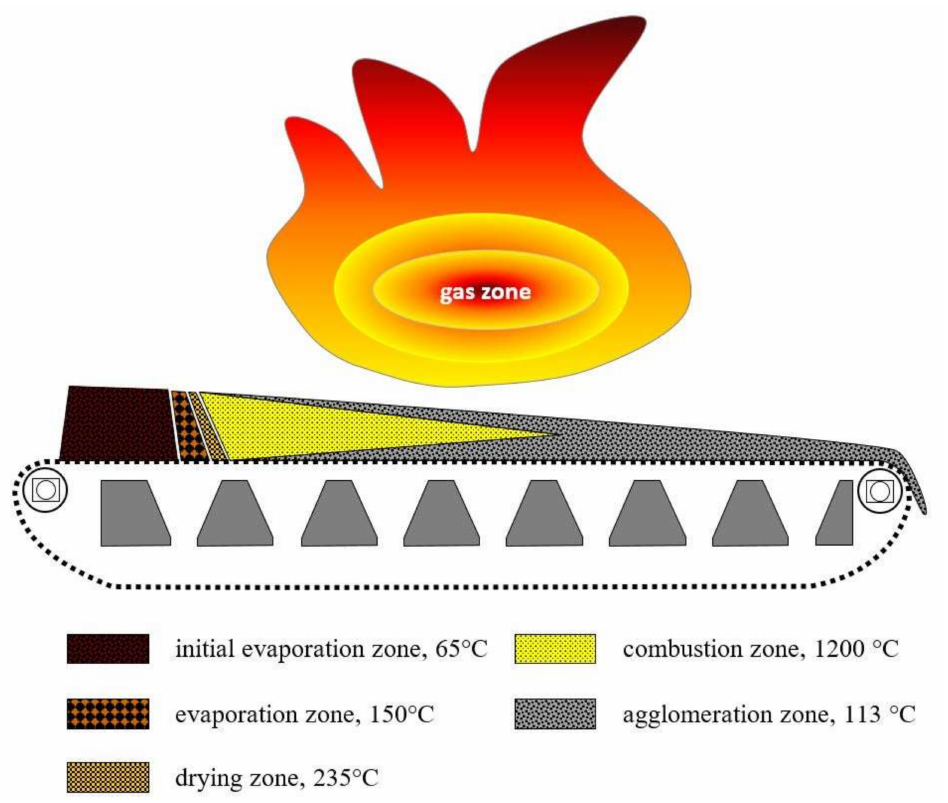
Figure 3. The illustrative distribution of the temperature of coal and slag on the grate of a stoker-boiler.